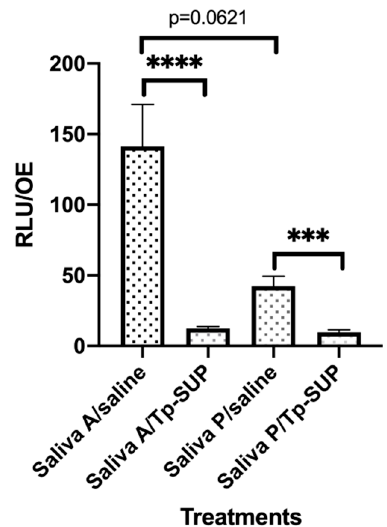
Figure 2. Early biofilm formation onto saliva-contaminated OE exposed or not to Tp-SUP. The saliva-contaminated OE were incubated for 23 h at 37 ◦ C + 5% CO 2 and then exposed to saline or Tp-SUP for additional 1 h, in the presence of CFDA, to allow fluorescence staining. Then, the OE were washed with warm saline and transferred in new wells. The plate was read by the Fluoroskan microplate reader and the fluorescence signal was recorded. The depicted values represent the mean ± SEM (RFU / OE) of 13–16 replicates obtained by 3 independent experiments. **** p < 0.0001; *** p < 0.001.